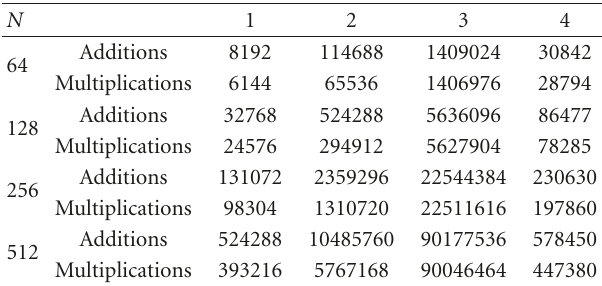
−→ −→ −→ −→ n , k ) = L 2 ( n , k , ± i 1 )